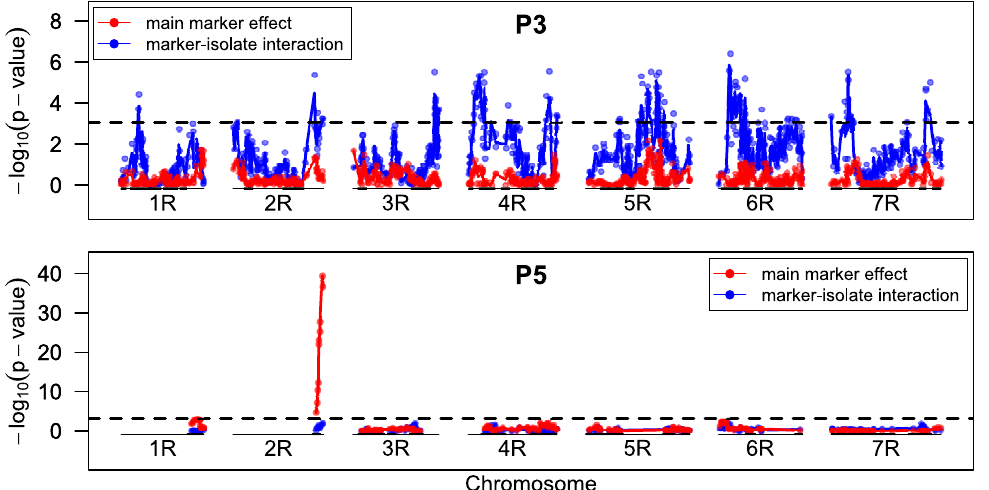
Figure 7. LOD-profiles for mapping of seedling resistance of stem rust in P3 and P5. Marker-wise p -values were calculated by comparing likelihood differences (anova) of a cumulative logit link model. Marker order was based on a consensus map from linkage maps of all populations (and populations from previous projects). The dashed line shows the global significance threshold (alpha = 0.05) adjusted for multiple testing by the simpleM